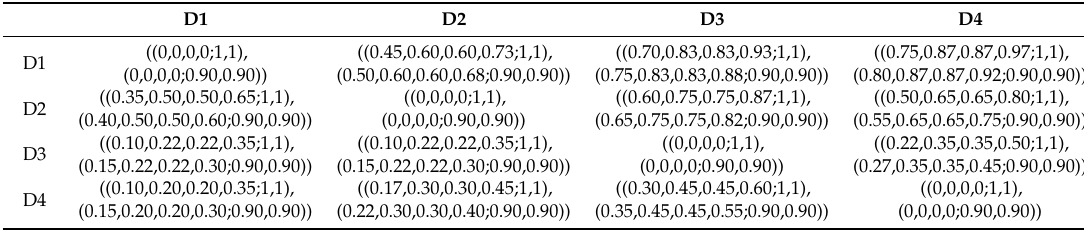
Table 4. Direct relation matrix for the dimensions.